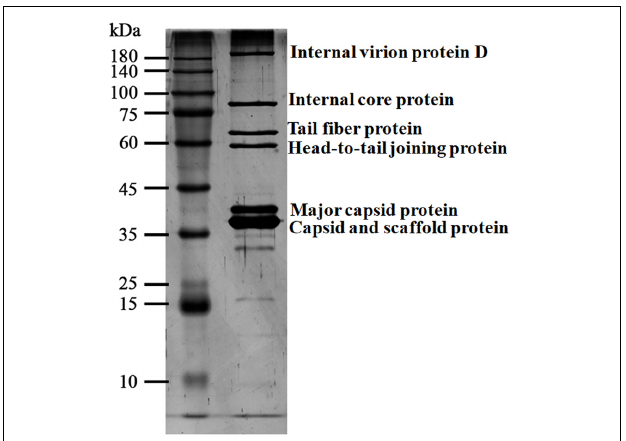
FIGURE 6 | Particle proteins of vB_ShiP-A7 separated by SDS-PAGE gel. The purified vB_ShiP-A7 particles were separated by SDS-PAGE and stained with silver. The six bands from top to bottom corresponding to different particle proteins of vB_ShiP-A7 are internal virion protein D, internal core protein, tail fiber protein, head-to-tail joining protein, major capsid protein, capsid, and scaffold protein. Protein molecular mass markers are indicated on the far